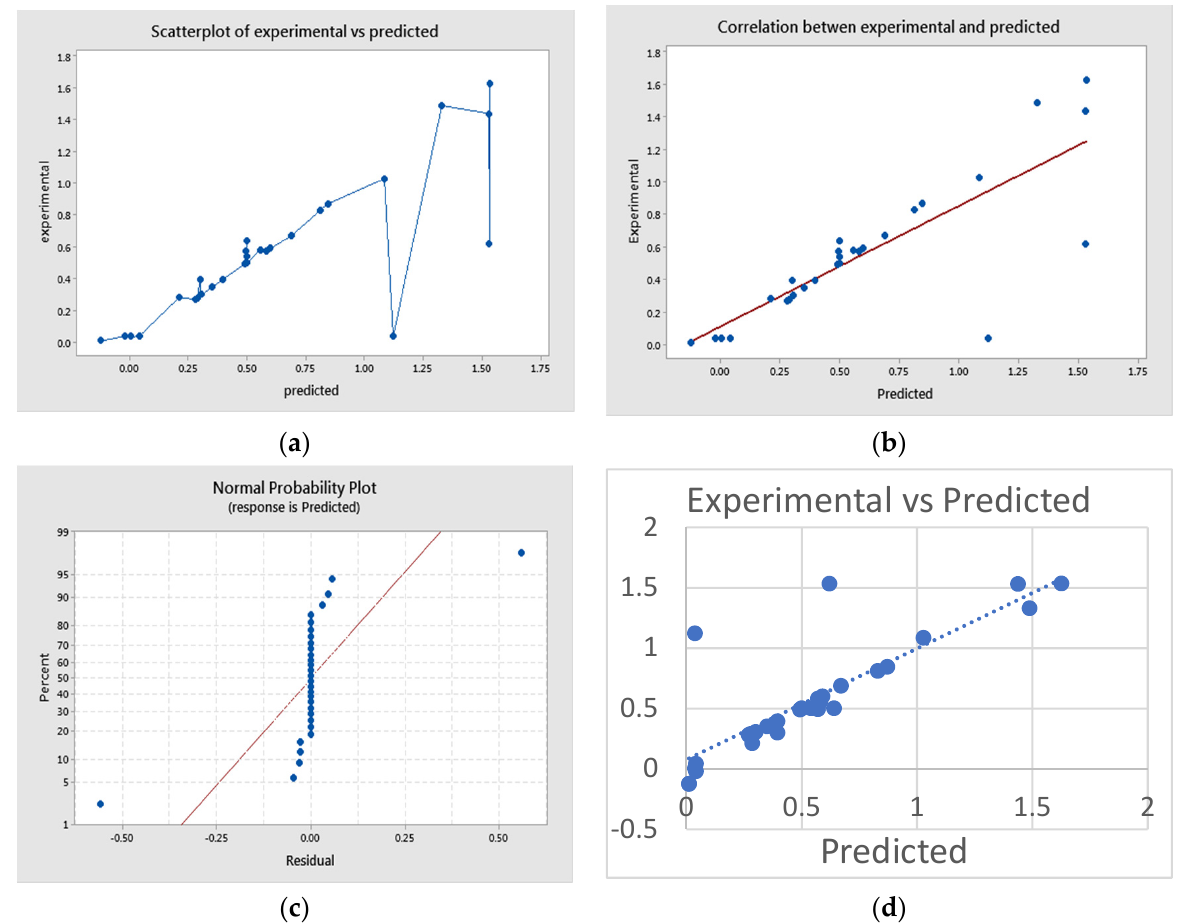
Figure 3. ( a ) Scatter plot of experimental versus predicted, ( b ) correlation between actual values and predicted values, ( c ) normal plot of residuals versus predicted values and ( d ) normal plot of predicted versus experimental values.